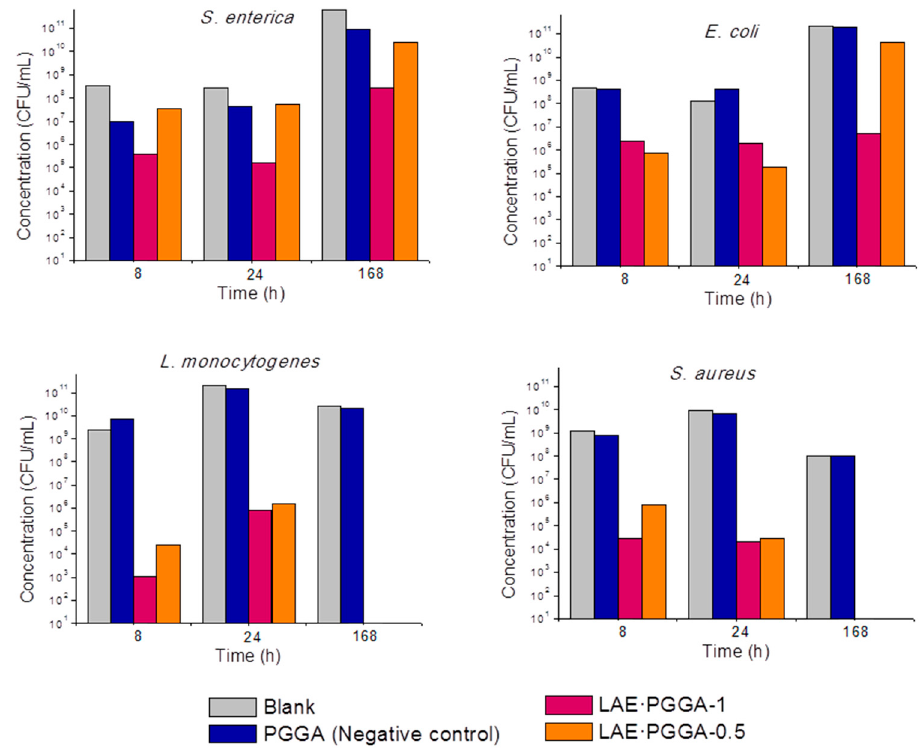
Figure 8. Antibacterial activity of LAE·PGGA-1 and LAE·PGGA-0.5 films against Gram-negative and Gram-positive bacteria expressed as concentration of colony forming units (CFU·mL − 1 ). Table 4. Bactericide activity of films made of LAE · PGGA complexes against Gram-negative and Gram-positive bacteria after 1 and 7 days of incubation at pH 7.4 and 37 ◦